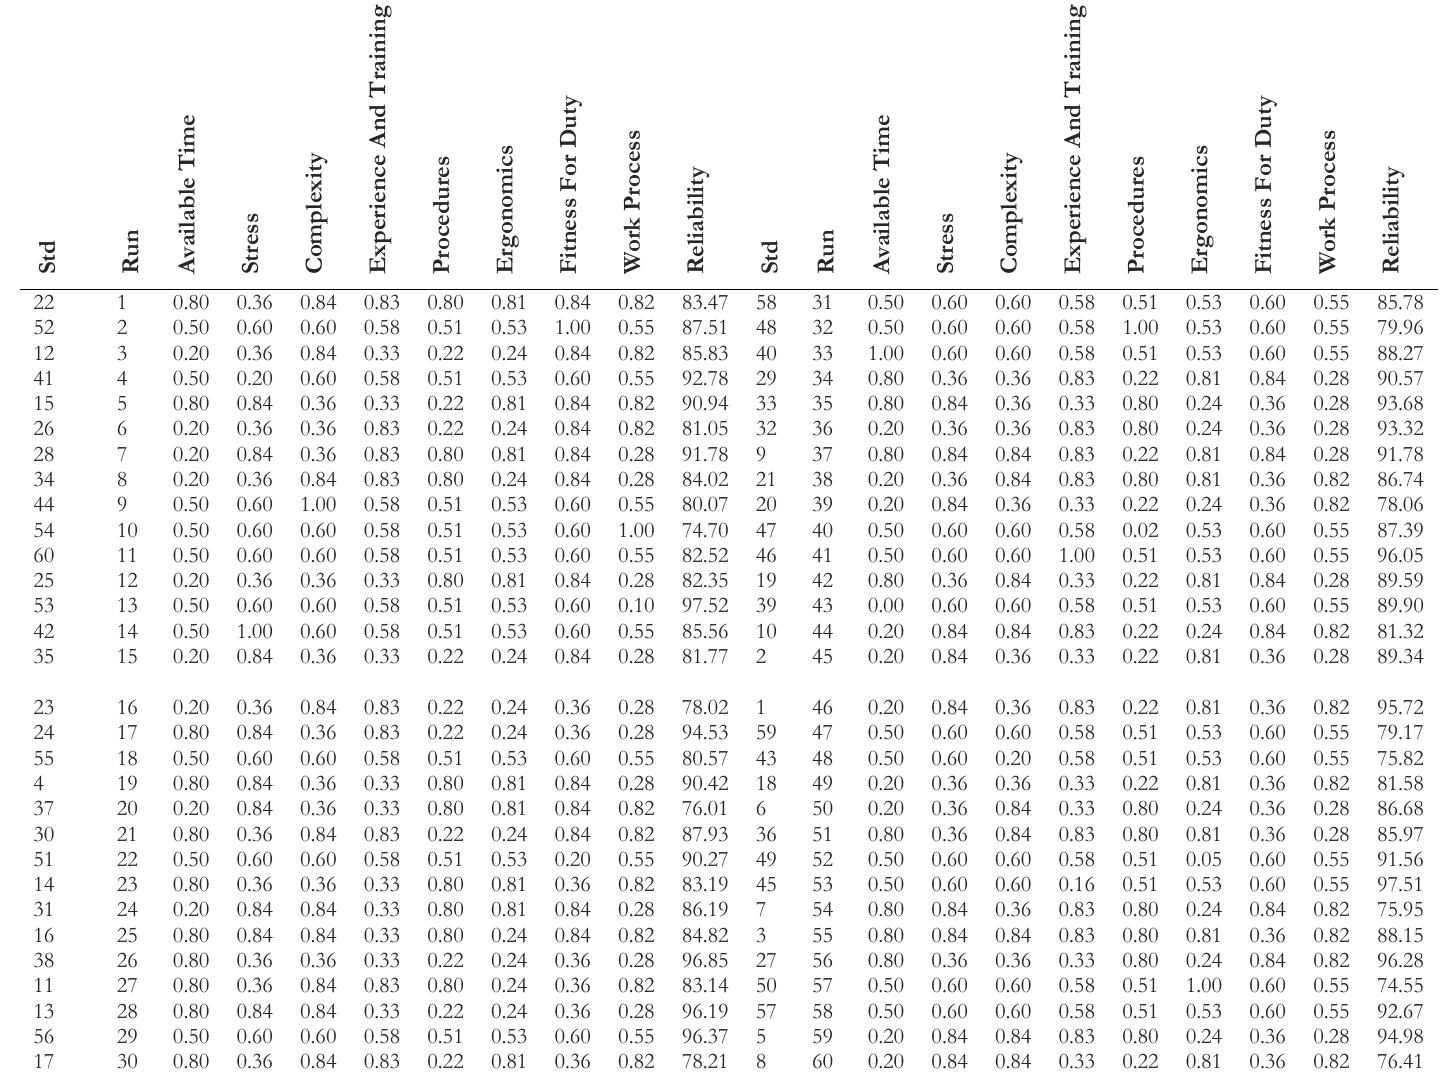
Table 4. The RSM design for 8